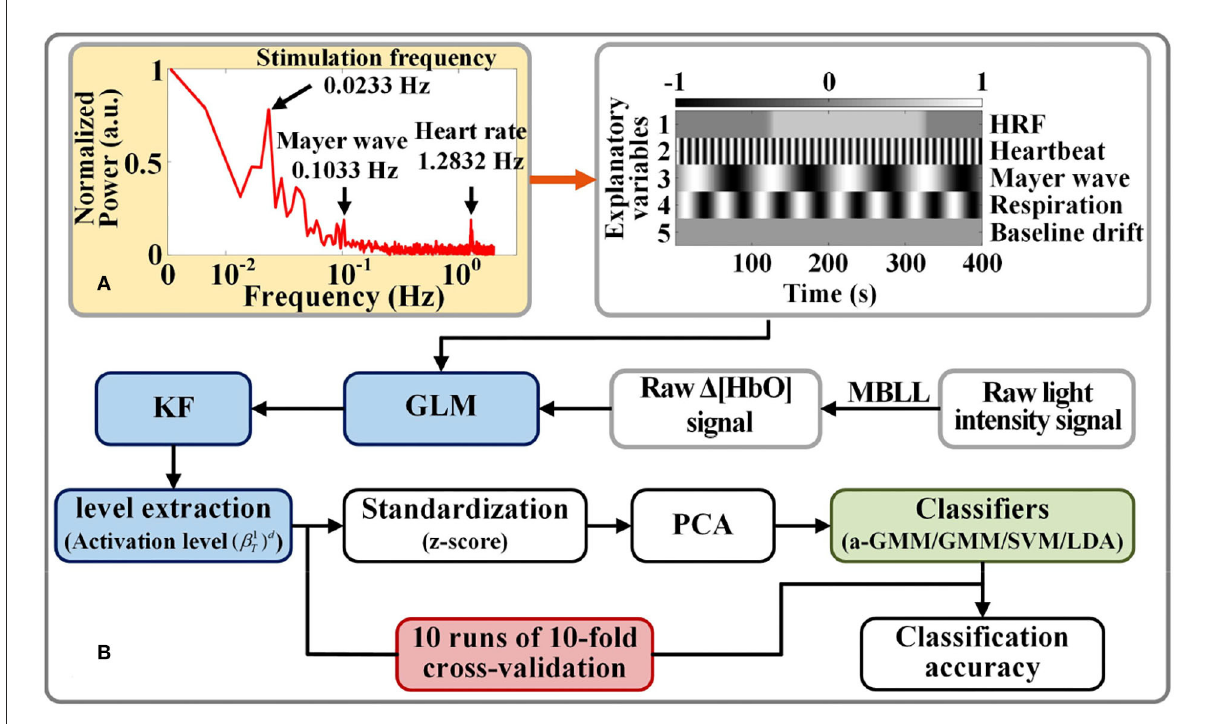
FIGURE4 Activation level feature extraction and classification strategy for fNIRS signals: (A) Example of a spectrogram of participant 1 for frequency selection of physiological interferences in the design matrix. (B) Flow chart of fNIRS signal classification based on level features.